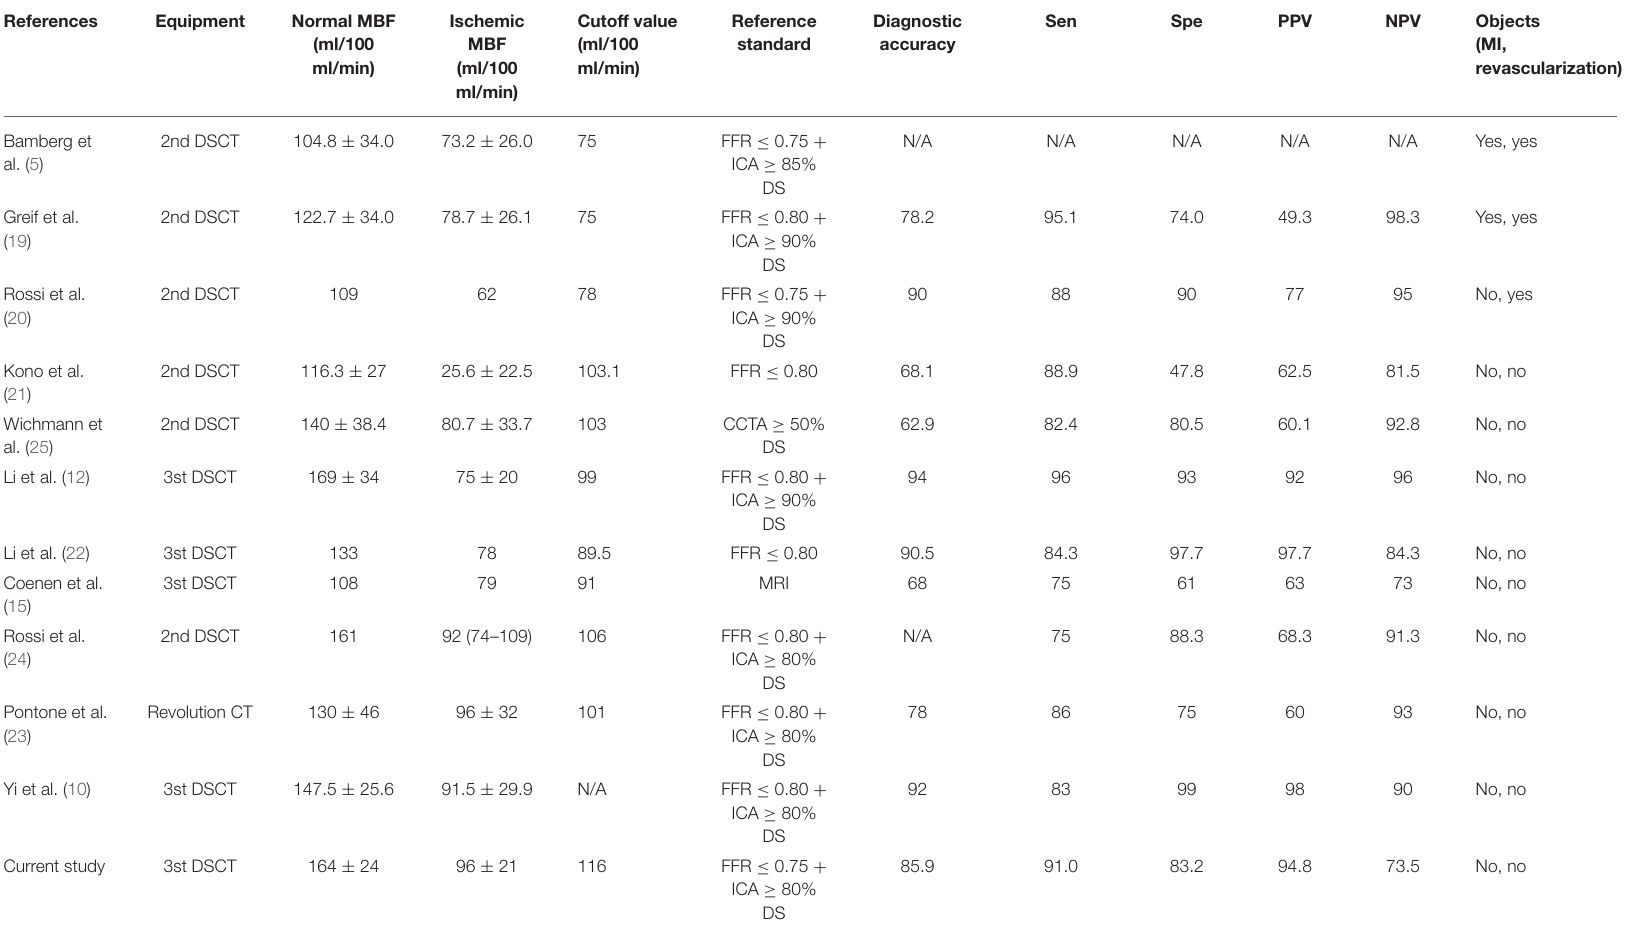
TABLE 4 | Quantitative myocardial blood flow and ischemic cut-off values of stress MBF assessed by